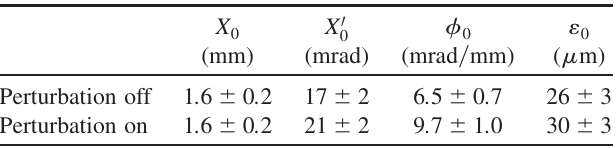
TABLE II. Beam parameters for the rectangular beam, mea- sured from phase-space tomography at the aperture plane. Note that X 0 is the 2 (cid:4) rms beam radius, X 0 0 is the slope of the beam envelope [Eq. (11)], (cid:6) 0 is the phase-space slope [Eq. (10)], and " 0 is the 4 (cid:4) rms emittance. The subscript ‘‘0’’ indicates that those measurements are conducted at z ¼ 0 cm